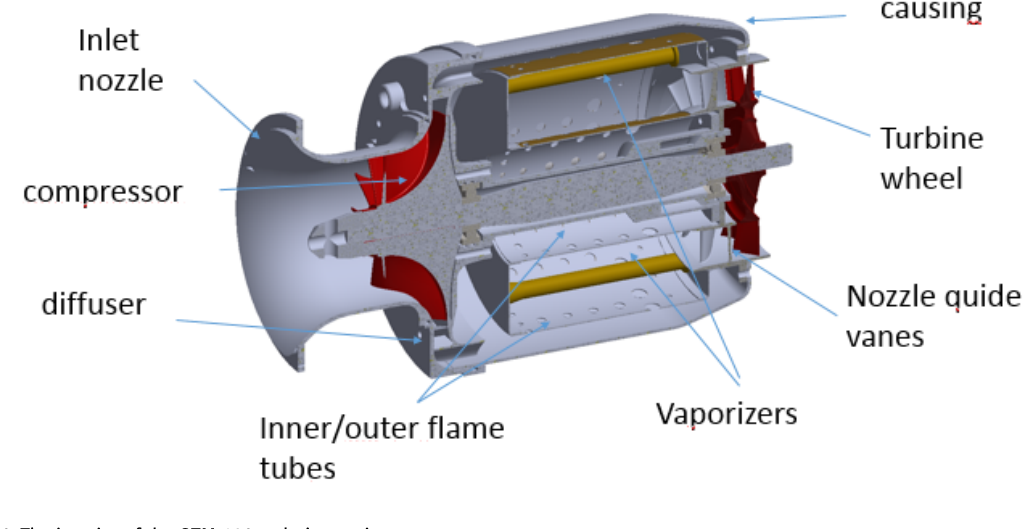
Figure 1: The interior of the GTM-140 turbojet engine.